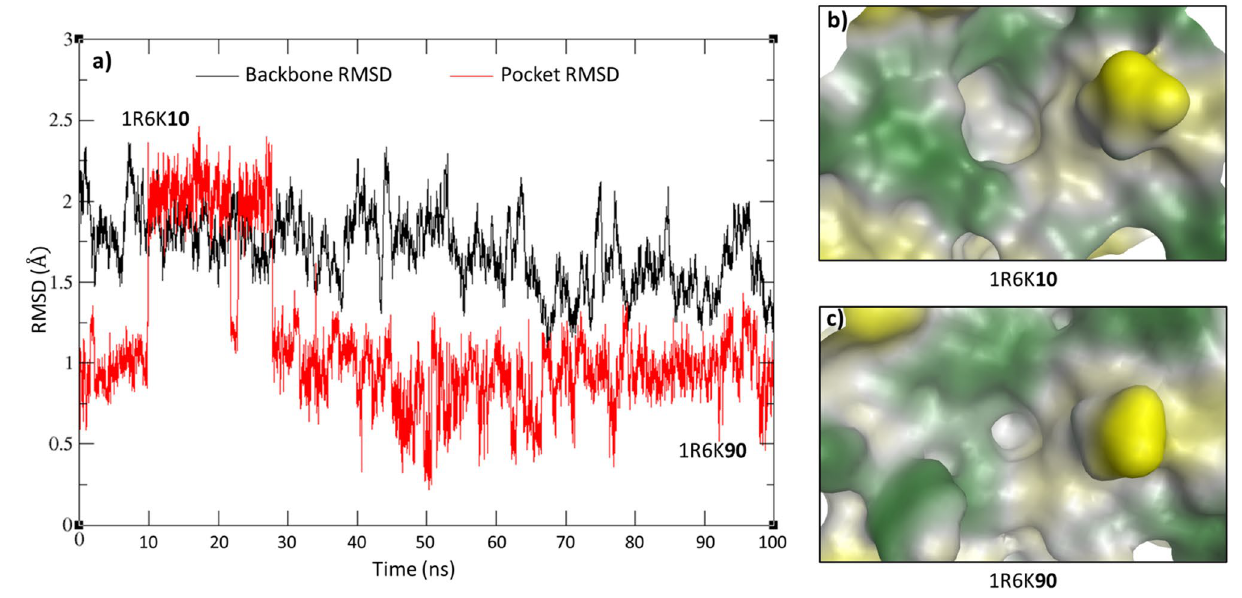
Figure 8. ( a ) The RMSD values of the protein backbone of HPV (PDB: 1R6K 36 ) over the 100 ns MD simulation, ( b) The HPV interface is clearly showing different topologies at the clustered structure at 10 ns compared to ( c ) the cluster at 90 ns.